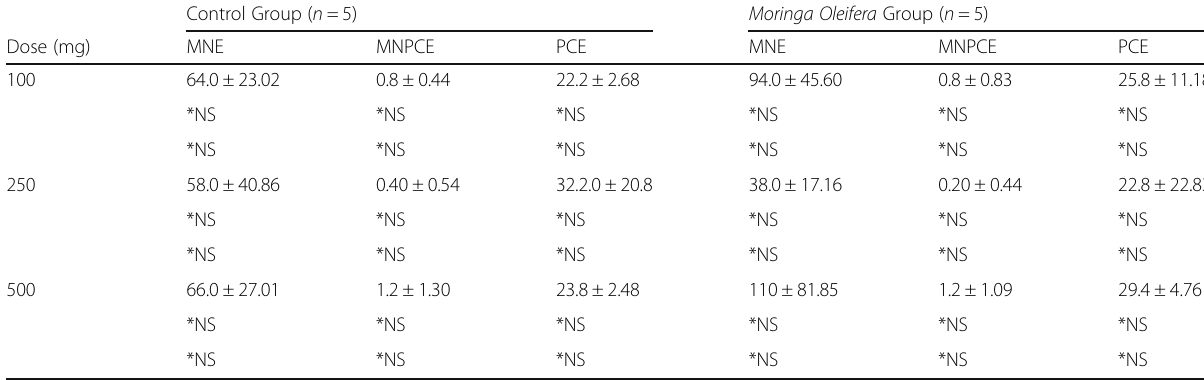
Table 1 MNE, MNPCE and PCE frequencies (%) Control Group ( n =